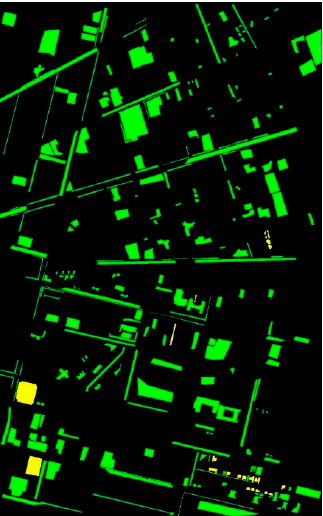
Figure 14. Reference samples for change detection. Changed/unchanged samples are labelled in yellow/green, respectively.